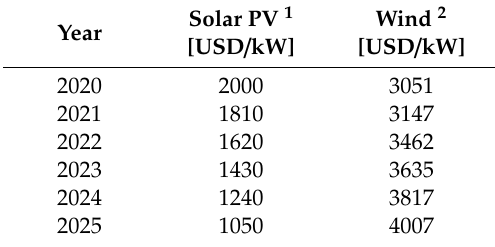
Table A4. Sources of the historical and forecasted